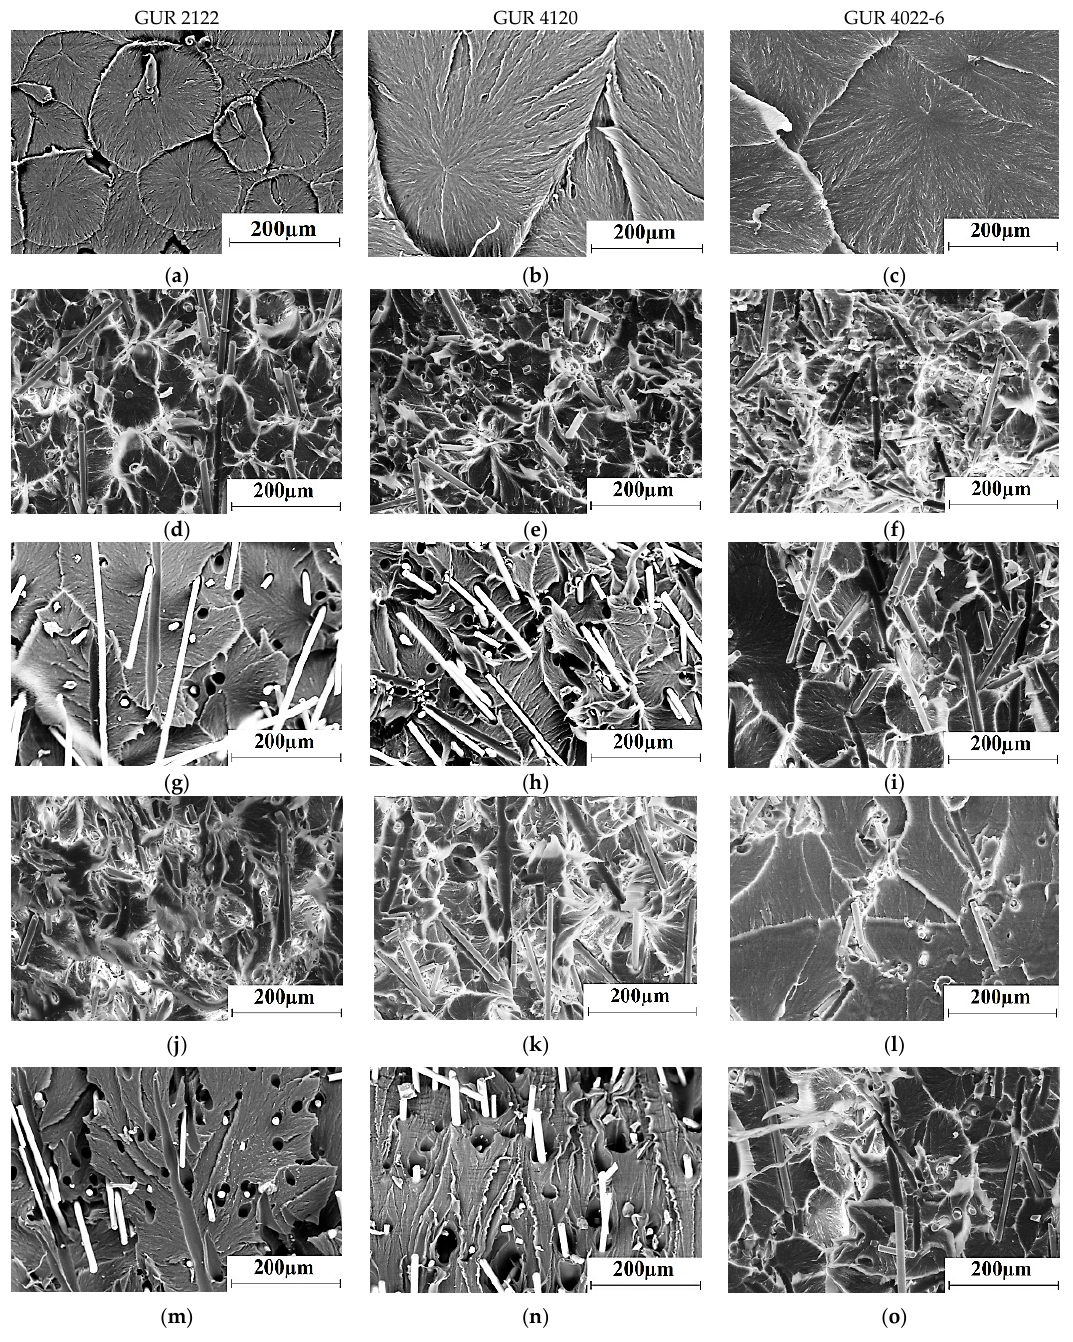
Figure 3. SEM micrographs of the sample permolecular structures: neat GUR 2122 ( a ), neat GUR 4120 ( b ), neat GUR 4022-6 ( c ); composites loaded with 10%: MGF annealed ( d, e, f ), LGF annealed ( g, h, i ), MGF annealed and treated with “KH-550” ( j, k, l ), and LGF annealed and treated with “KH-550” ( m, n, o ).